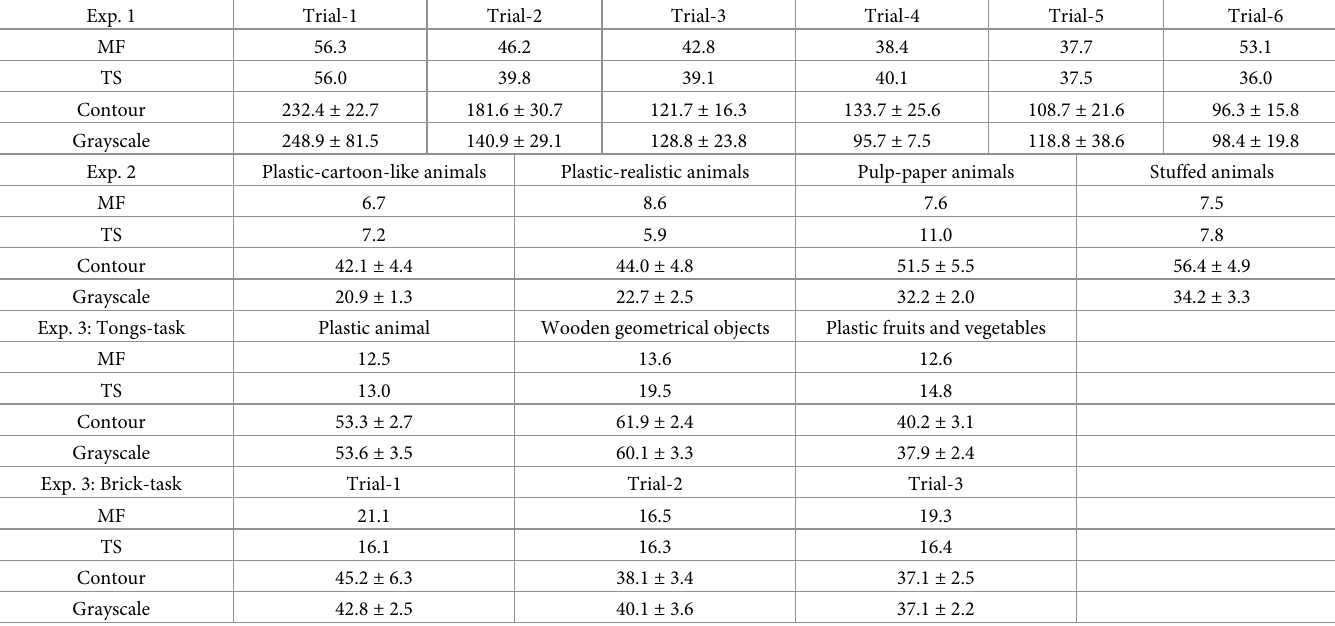
Table 1. Response times (sec) of MF and TS, under a more natural viewing condition, measured in sessions run when the AR device was not worn. The response time with the two image filters in Experiments 1, 2, and 3 are also shown for comparison (average ± standard error). Exp.